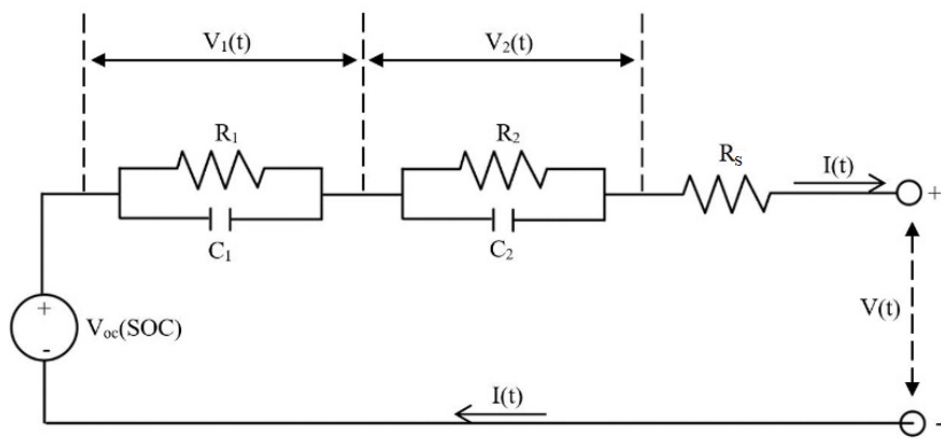
Figure 1. Diagram of Equivalent Circuit Model [9].